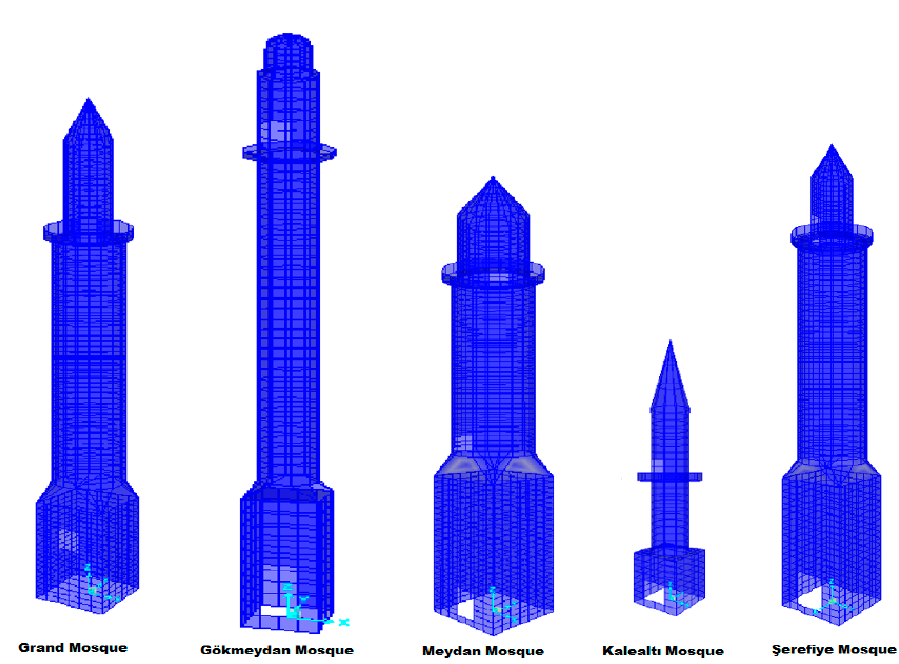
Figure 8. Dimensions of Five Minarets.